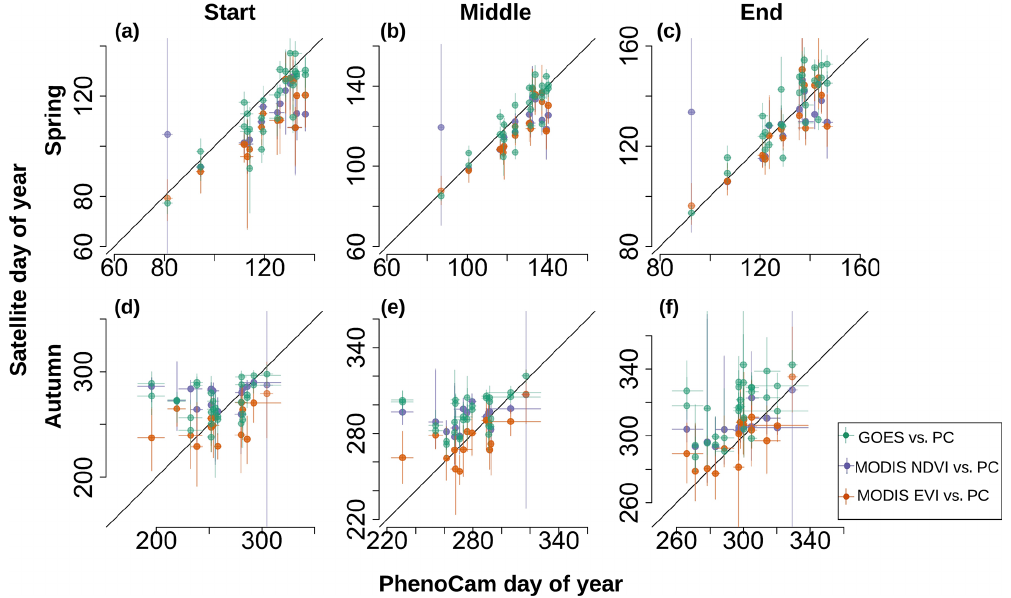
Figure 5. Scatter plots showing how the different data sources compare for their estimation of spring start (a) , middle (b) , and end (c) and autumn start (d) , middle (e) , and end (f) . Median transition dates are indicated by the point, and 95% credible intervals are indicated by the lines. The x axis gives the day of year of the PhenoCam (PC) transition and the y axis indicates the day of year of the different satellite data sources, which are color-coded as indicated in the legend. Spring correlations are much higher than autumn ones, and GOES dates are more correlated at the start and middle of spring (a, b) but are slightly biased late at the end of spring (c)